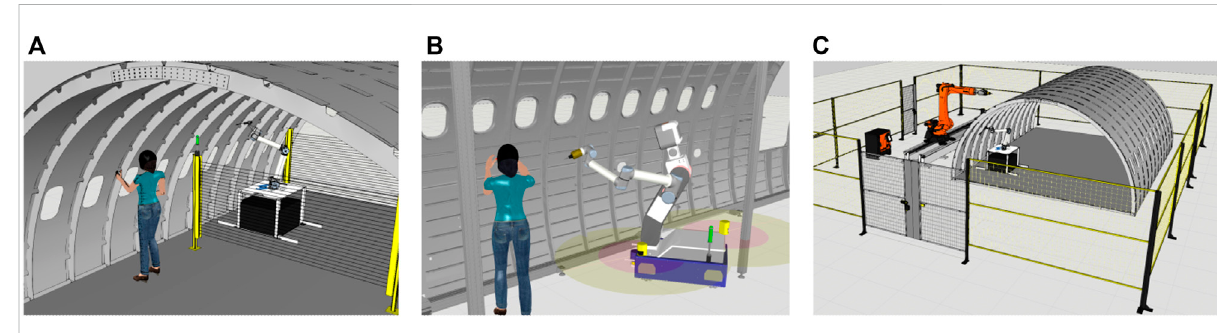
FIGURE 1 Co-existence with human workers using fi xed sensor placement for separation (A) ; Autonomous robot with fully dynamic safety space (B) ; Implementation using a non-collaborative setup (C)